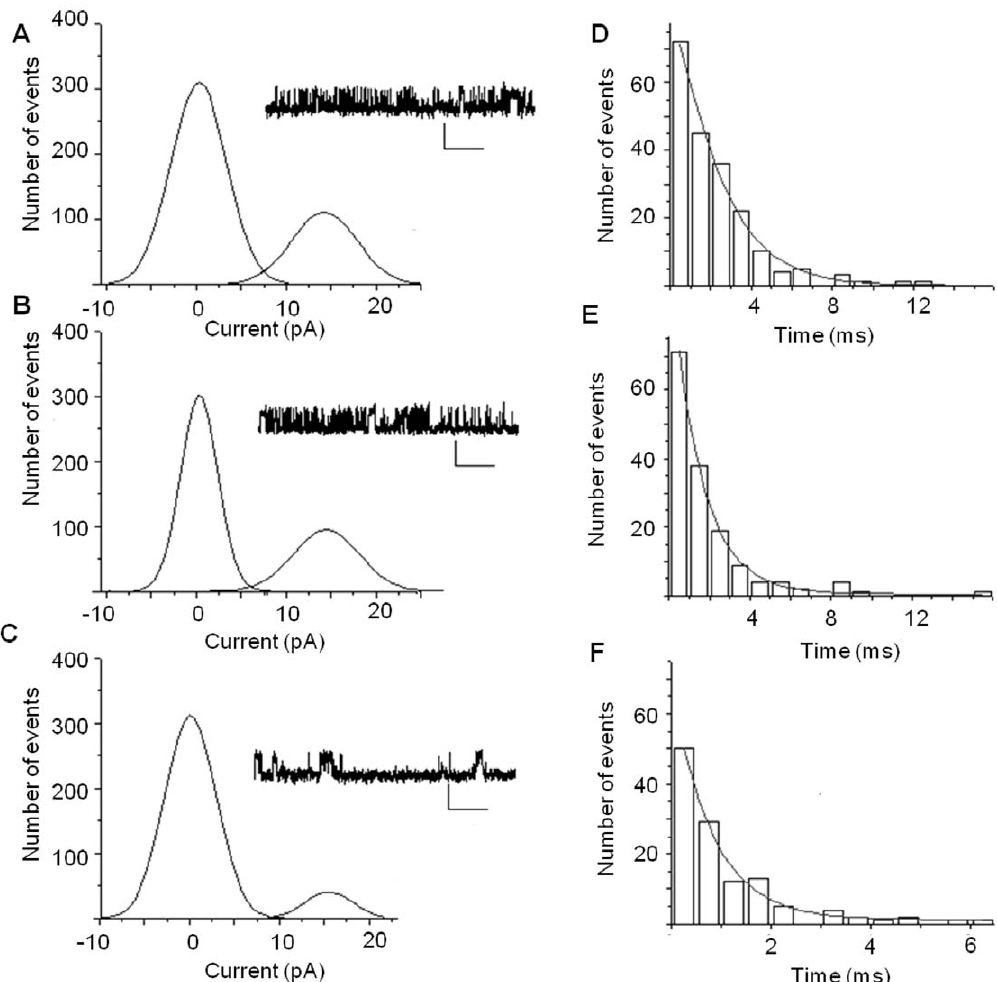
Figure 7. Cholinergic depletion in the MS leads to alterations in NMDA elicited synaptic single channel currents. Sample traces and respective current amplitude histograms of (A) non-infused control rats, (B) saline infused rats, and (C) 192-saporin infused rats show that channel open peak (right peaks in each histogram) in the 192-saporin data is reduced demonstrating a decrease in open probability (Calibration: each 4 pA, 200 ms). Dwell open time histograms of NMDA currents were best fitted with two terms for (D) non-infused, (E) saline infused, and (F) 192 saporin infused data. The NMDA elicited currents were confirmed by addition of APV to the extracellular solution to completely block these currents (Data not